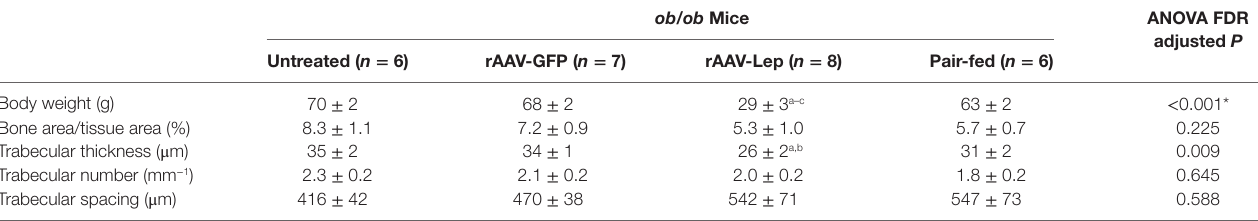
TaBle 1 | effects of hypothalamic leptin gene therapy (raaV-lep) on body weight and cancellous bone architecture in distal femur metaphysis in ob/ob male mice at 30 weeks post-vector